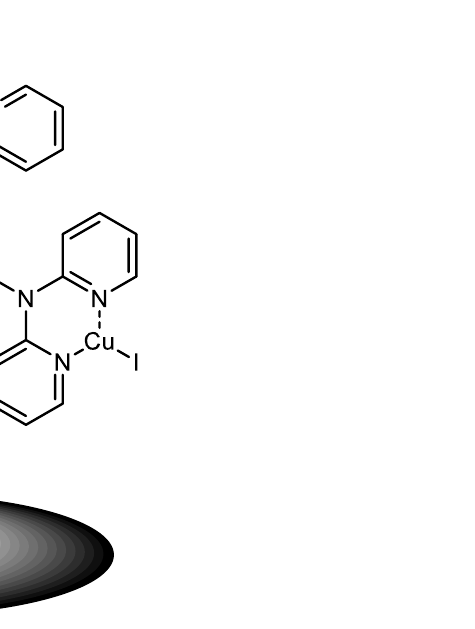
Figure 9. CuI/py catalyst immobilized on mesoporous SBA-15 surface (CuI/py on SBA-15) [114].